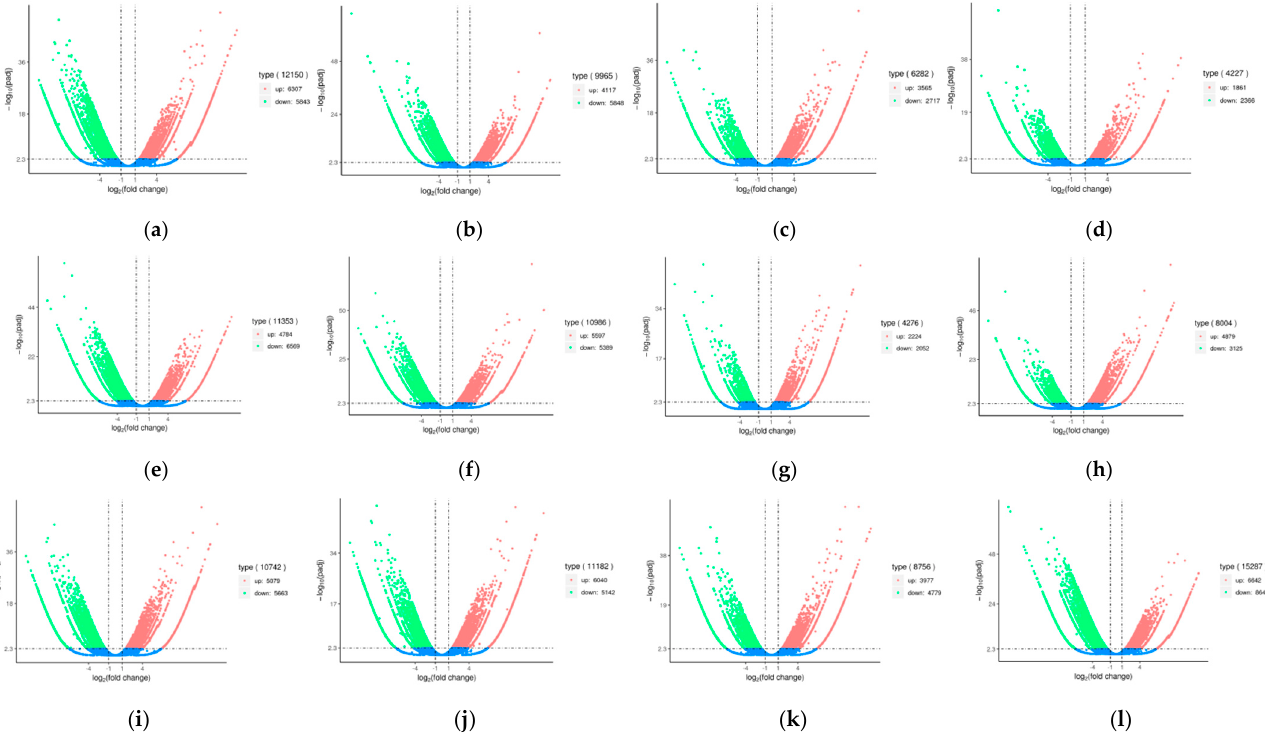
Figure 4. Venn diagram comparing differentially expressed genes between samples. Co-expression of ( a ) ‘TRI-2025 ′ , ‘Tambi-2 ′ , and ‘Tambi-2 ′ × ‘TRI-2025 ′ , ( b ) ‘Tambi-2 ′ , ‘Tambi-2 ′ × ‘Cinyiruan-143 ′ , ‘Tambi-2 ′ × ‘TRI-2025 ′ , and ‘Tambi-2 ′ × ‘Suka Ati-40 ′ , ( c ) ‘Tambi-2 ′ , ‘Kiara-8 ′ × ‘Sukoi’, ‘Tambi-1 ′ × ‘Kiara-8 ′ , and ‘Tambi-2 ′ × ‘Suka Ati-40 ′ , ( d ) ‘Tambi-2 ′ , ‘TRI-2025 ′ , ‘Kiara-8 ′ × ‘Sukoi’, ‘Tambi-2 ′ × ‘Suka Ati-40 ′ , and ‘Tambi-1 ′ × ‘Kiara-8 ′ , ( e ) ‘Tambi-2 ′ × ‘Suka Ati-40 ′ , ‘Tambi-1 ′ × ‘Kiara-8 ′ , ‘Kiara-8 ′ × ‘Sukoi’, ‘Tambi-2 ′ × ‘TRI-2025 ′ , and ‘Tambi-2 ′ × ‘Cinyiruan-143 ′ . Furthermore, volcano plots were generated to display the significant differences and up and down-regulated genes between pairwise comparison samples. DEGs of ‘Tambi-2 ′ were up-regulated compared to ‘TRI-2025 ′ , ‘Tambi-2 ′ × ‘Cinyiruan-143 ′ , and ‘Tambi-1 ′ × ‘Kiara-8 ′ , while down-regulated compared to ‘Tambi-2 ′ × ‘Suka Ati-40 ′ , ‘Tambi-2 ′ × ‘TRI-2025 ′ , and ‘Kiara-8 ′ × ‘Sukoi’. DEGs of ‘Tambi-2 ′ × ‘Suka Ati-40 ′ were up-regulated compared to ‘Tambi-2 ′ × ‘TRI-2025 ′ and ‘Tambi-2 ′ × ‘Cinyiruan-143 ′ , while down-regulated compared to ‘Kiara-8 ′ × ‘Sukoi’. DEGs of ‘Tambi-2 ′ × ‘TRI-2025 ′ were up-regulated compared to ‘Tambi-2 ′ × ‘Cinyiruan-143 ′ , while down-regulated compared to ‘Kiara-8 ′ × ‘Sukoi’ and ‘Tambi-2 ′ × ‘Suka Ati-40 ′ . DEGs of ‘Kiara-8 ′ × ‘Sukoi’ were up-regulated compared to ‘Tambi-2 ′ × ‘Cinyiruan-143 ′ , ‘Tambi-2 ′ × ‘TRI-2025 ′ , and ‘Tam- bi-2 ′ × ‘Suka Ati-40 ′ (Figure 5).